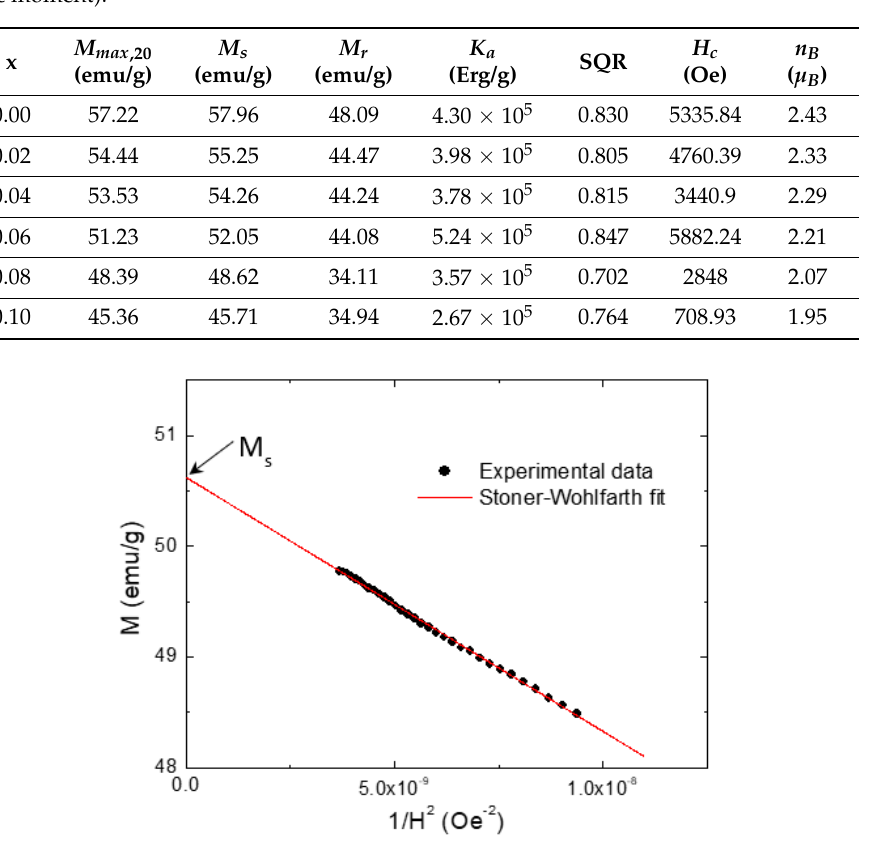
Figure 8. Magnetization versus applied field of ± 20 kOe, M(H), for the Co 0.5 Ni 0.5 Fe 2 − x O 4 (0.0 ≤ x ≤ 0.10) nanoparticles at RT. Table 3. The deduced magnetic parameters of the Co 0.5 Ni 0.5 Nb x Fe 2 − x O 4 (0 ≤ x ≤ 1.0) nanoparticles at 10 K ( M max ,20 : max magnetization at 20 kOe, Ms : saturation magnetization, Mr : remanence magnetization, Ka : magnetic anisotropy constant, SQR: squareness ratio, H c : coercivity, and n B : magnetic moment).